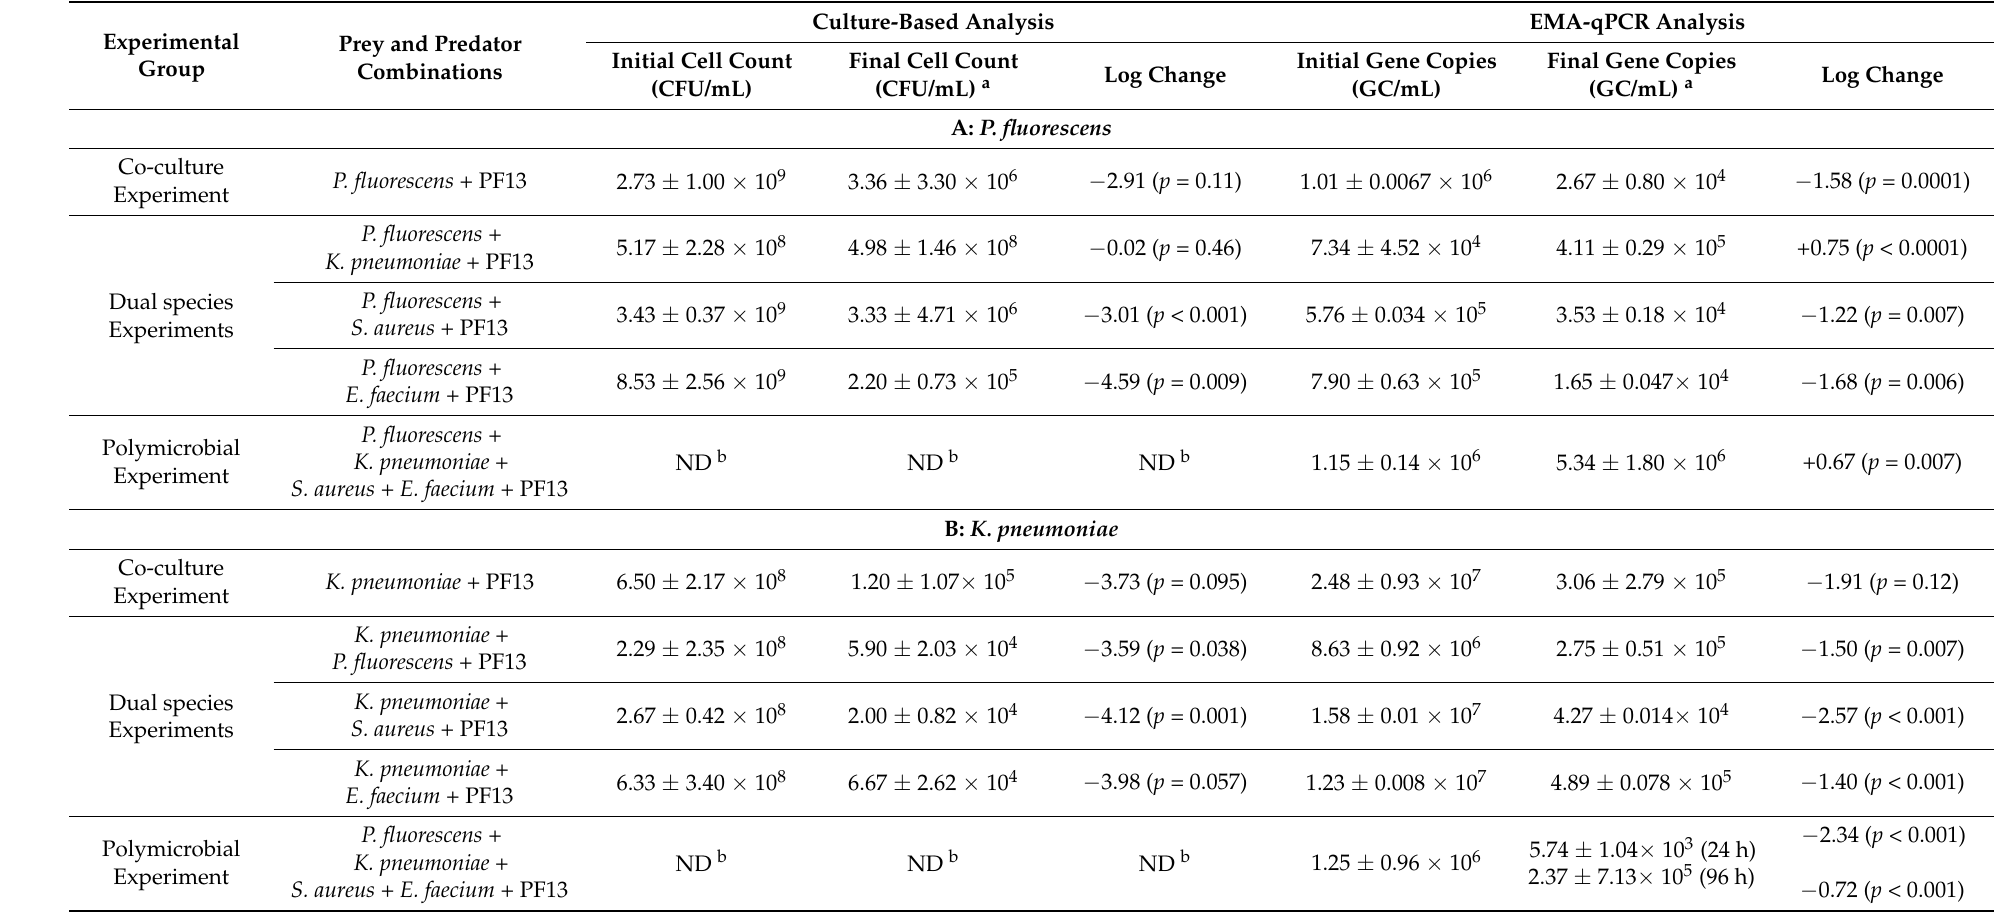
Table 2. Cell counts and gene copies ( ± standard deviation) of the Gram-negative [ Pseudomonas fluorescens (A) and Klebsiella pneumoniae (B)] and